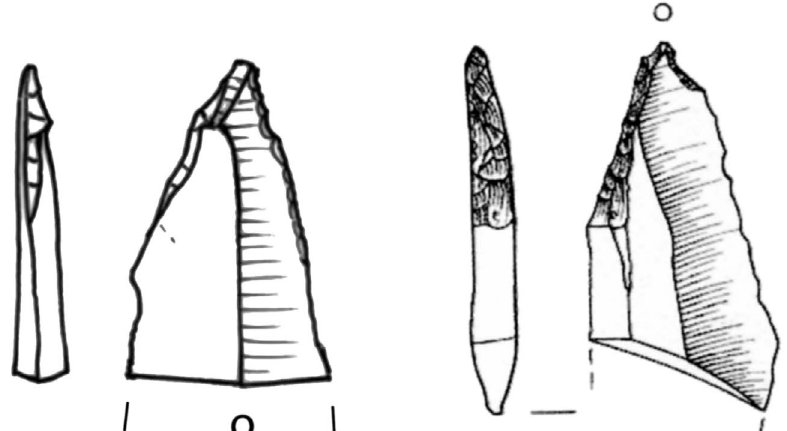
Figure 6. Left: A piece with oblique truncation from Nethermills Farm (CAT 78/019: length 21mm). Right: one from Howburn (CAT 795: length